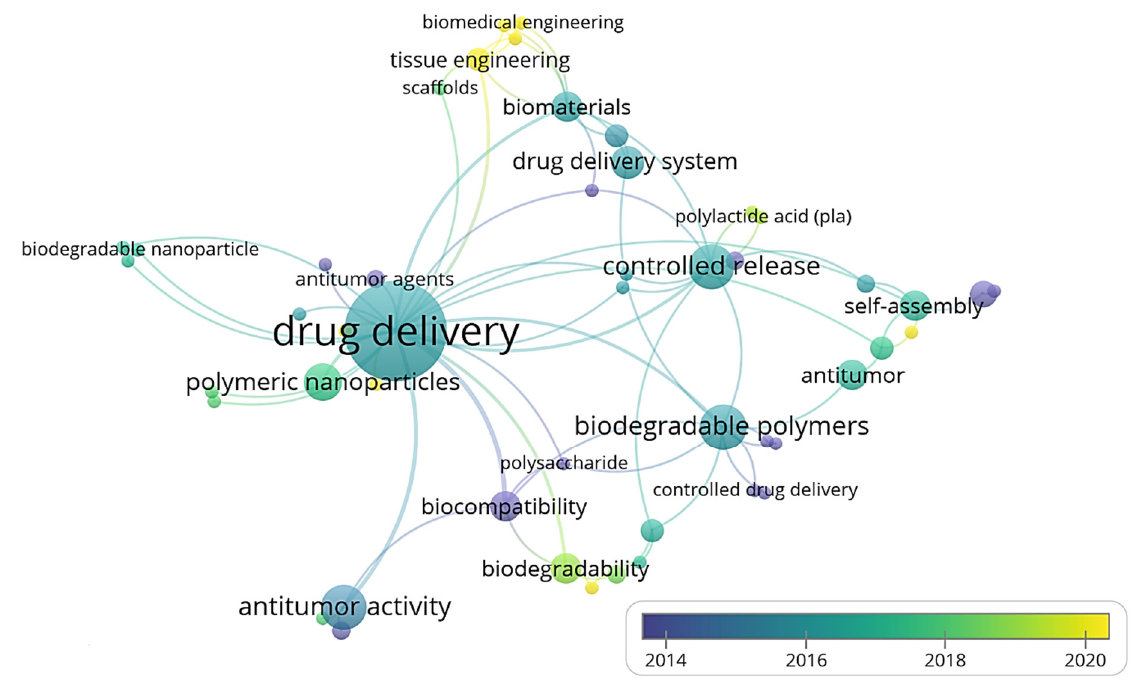
Figure 35. Antitumor drug delivery of biodegradable and natural polymeric biomaterials in hard tissue engineering.